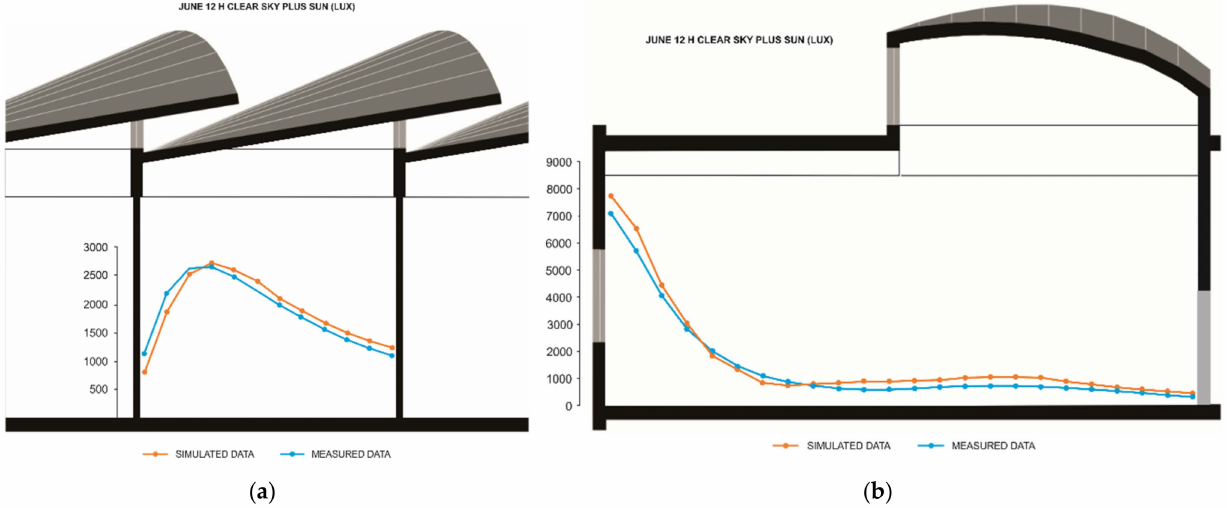
Figure 12. The comparison of measured and simulated data for partly cloudy sky at midday on 21 June. ( a ) Transverse axis; ( b ) longitudinal axis. Source: the